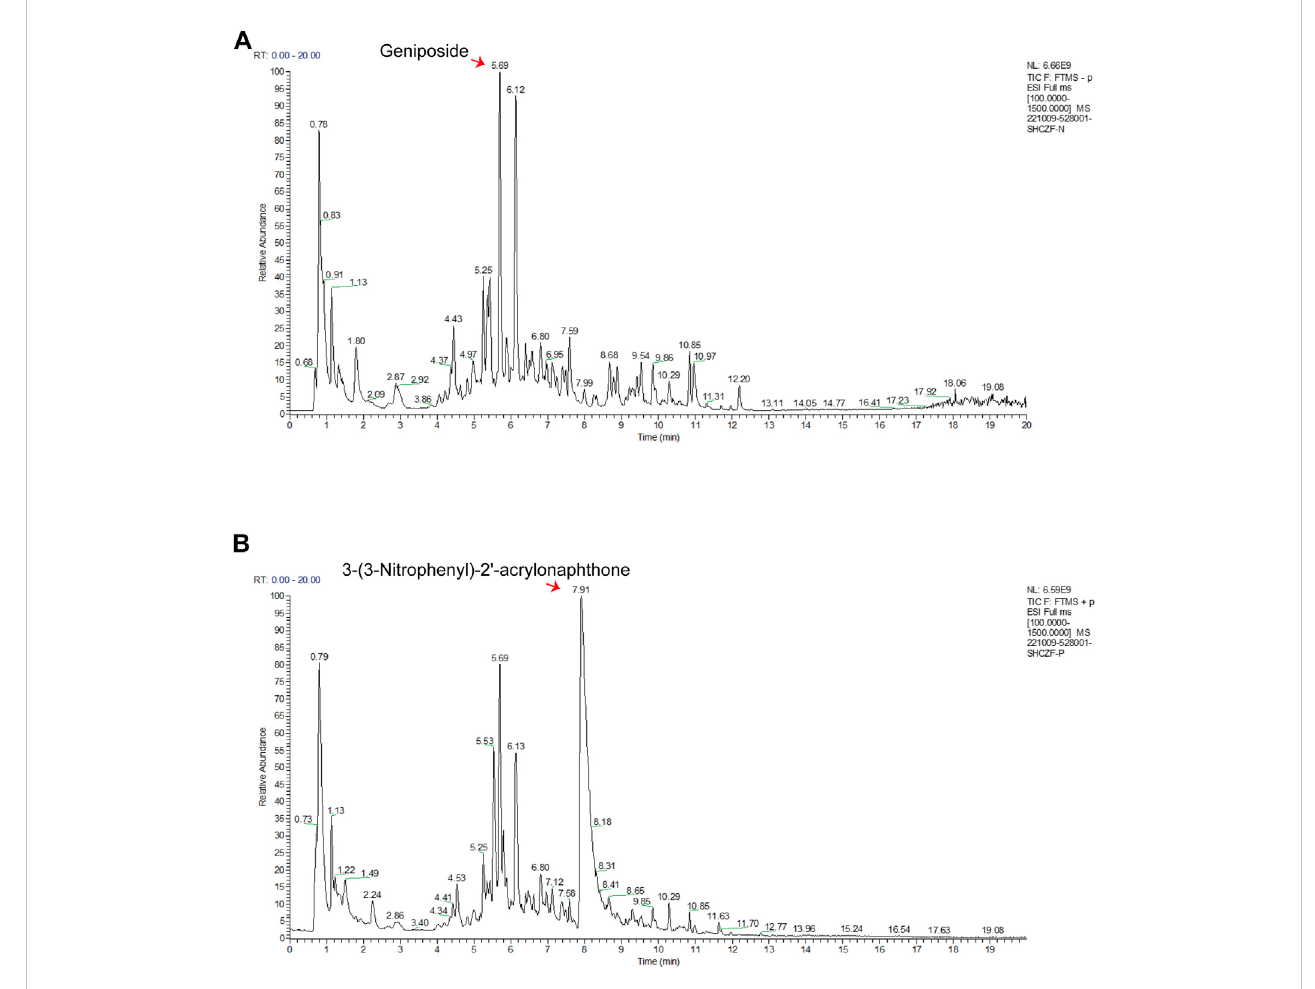
FIGURE 2 The results of HPLC-MS/MS. (A) Total ion current (TIC) chromatograms in negative mode, (B) TIC chromatograms in positive mode.